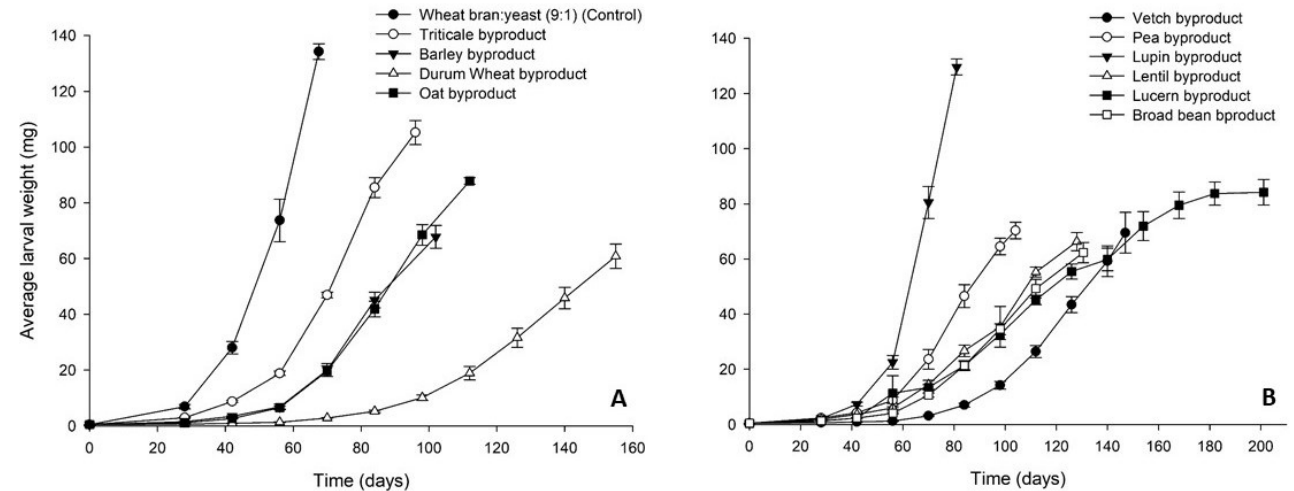
Figure 1. Average larval weight (mg) of Tenebrio molitor larvae reared on byproducts of the seed cleaning process of cereals ( A ) and legumes ( B ) or a mixture of wheat bran and yeast (9:1) (control). In all cases, values represent means ± SEM (n = 6).